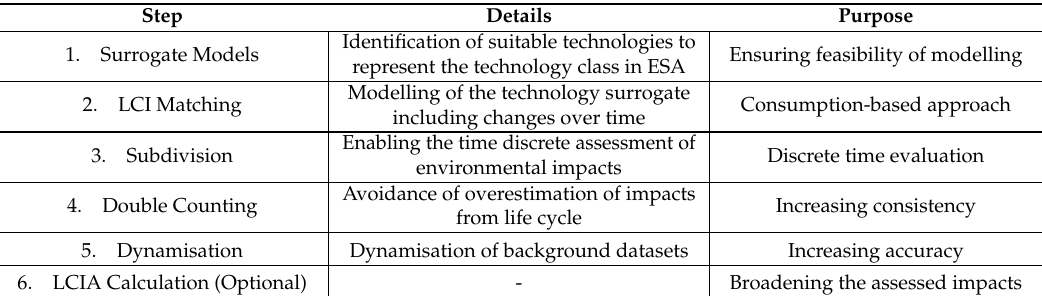
Table 1. Short description of the alignment of the Life Cycle Inventory (LCI) dataset for the integration into